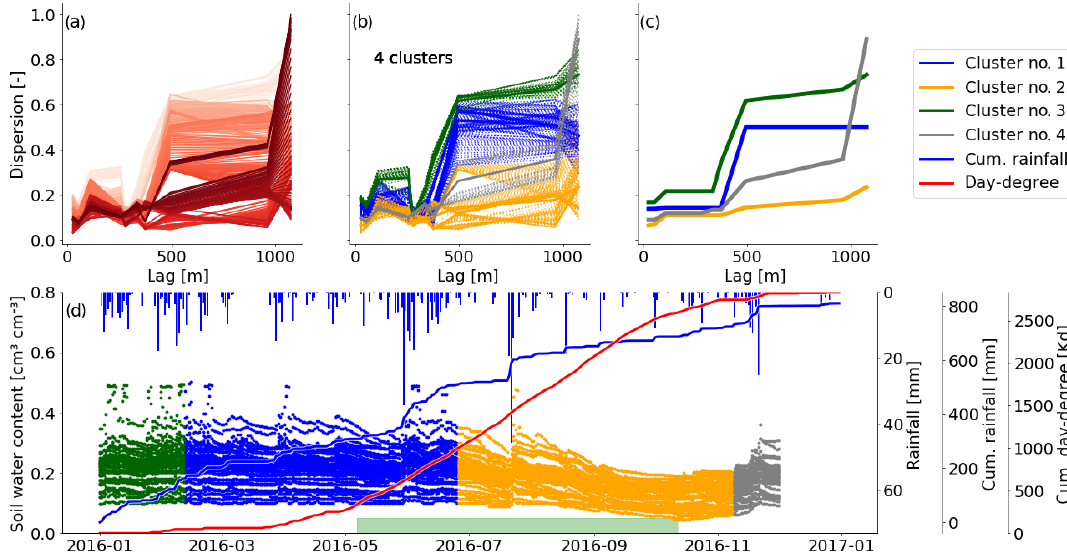
Figure 3. Spatial dispersion functions in 30cm for 2016 based on a window size of 30d. (a) Spatial dispersion function for each position of the moving window. The red color saturation indicates the window position. The darker the red, the later in the year. (b) The same dispersion functions as presented in (a) . Here the color indicates cluster membership as identified by the mean shift algorithm. (c) Compressed spatial dispersion information represented by corrected cluster centroids. The colors match the clusters as presented in (b) . (d) Soil moisture time series of 2016 in 30cm depth. The colors identify the cluster membership of the spatial dispersion function of the current window location and match the colors in (b) and (c) . The bars on the top show the daily precipitation sums. The solid blue line is the cumulative daily precipitation sum and the red line the cumulative sum of all mean daily temperatures > 5 ◦ C. The green bar marks the assumed vegetation period. It covers the dates where the cumulative day-degree sum is > 15% and < 90% of the maximum.